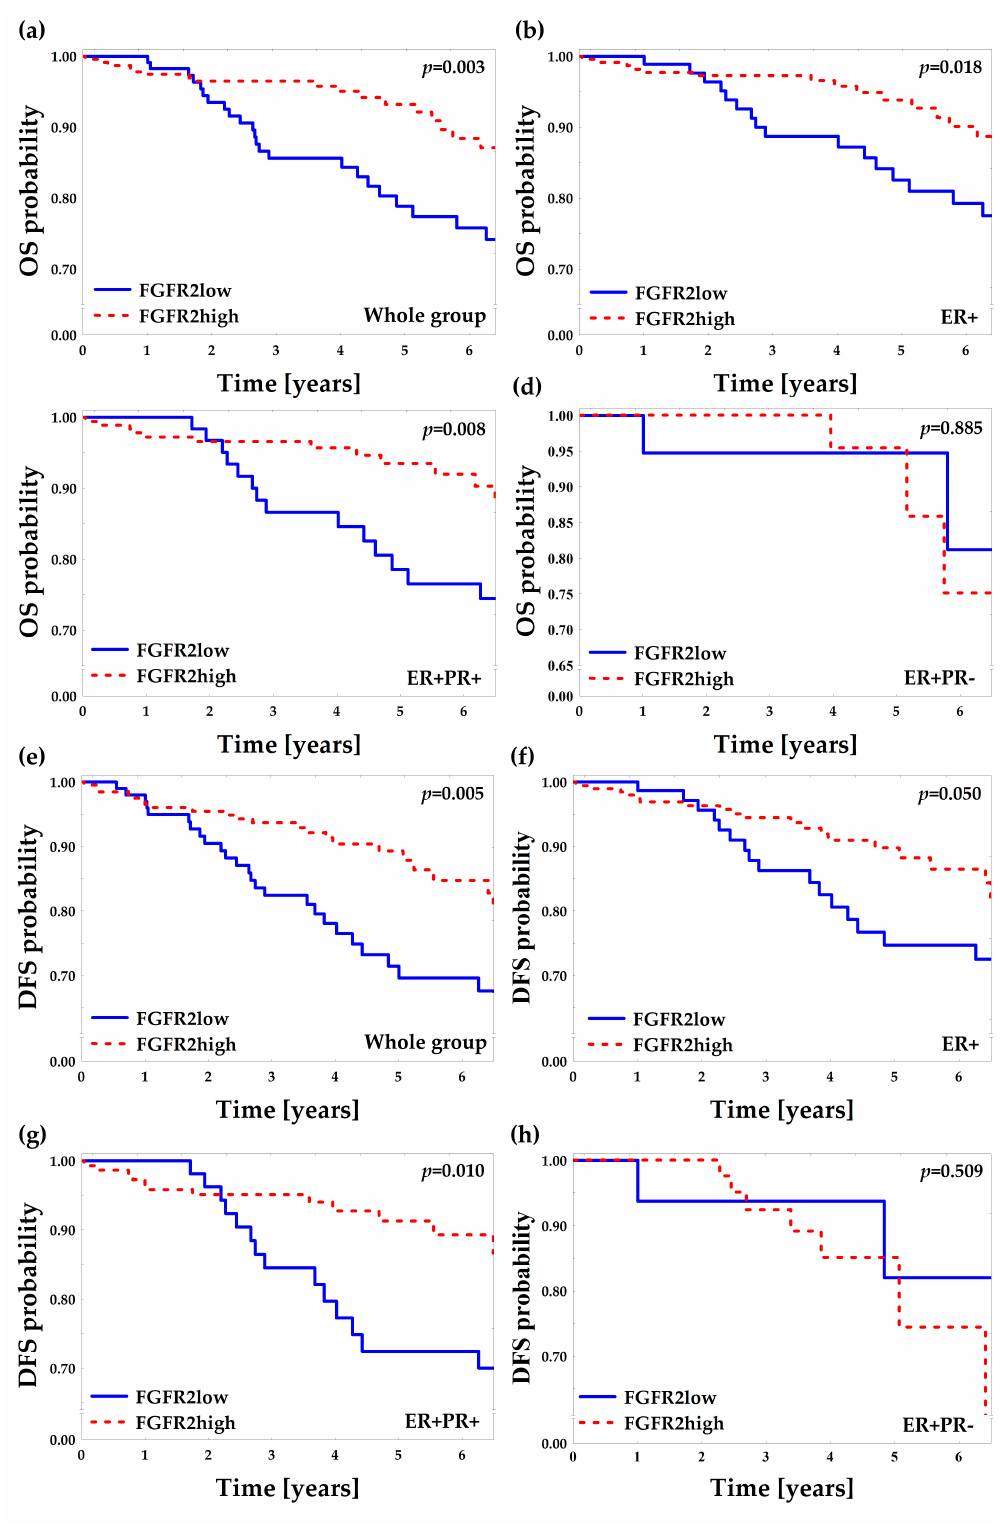
Figure 4. Kaplan–Meier curves for overall survival (OS) and disease-free survival (DFS) probability 1 regarding FGFR2low and FGFR2high patients (divided by 1st tercile of FGFR2 H-score). “ER + ” subgroup included all ER + patients regardless of PR status and it comprised ER + PR + and ER + PR − subgroups. p -values were calculated using log-rank test. ( a ) OS in the whole group; ( b ) OS in the ER + group; ( c ) OS in ER + PR + group; ( d ) OS in ER + PR − group; ( e ) DFS in the whole group; ( f ) DFS in the ER + group; ( g ) DFS in the ER + PR + group; ( h ) DFS in the ER + PR −